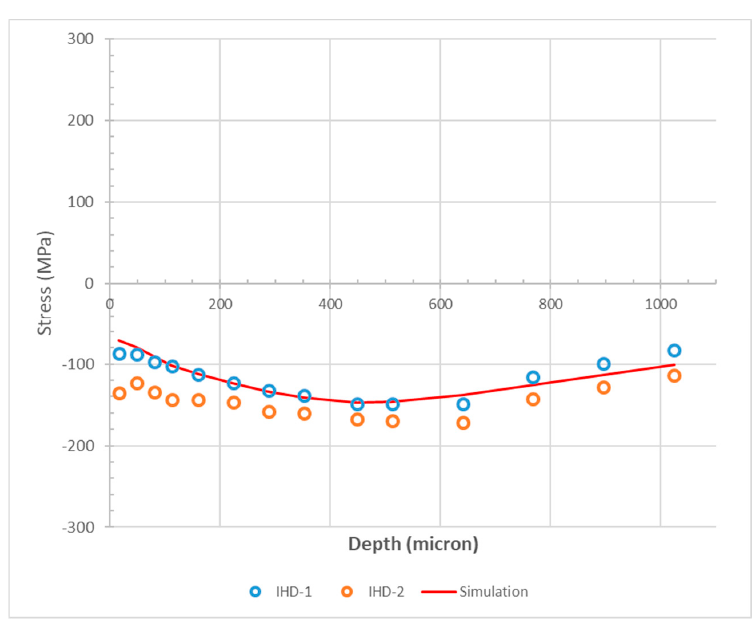
Figure 3. Comparison of predicted residual stresses against measured values.